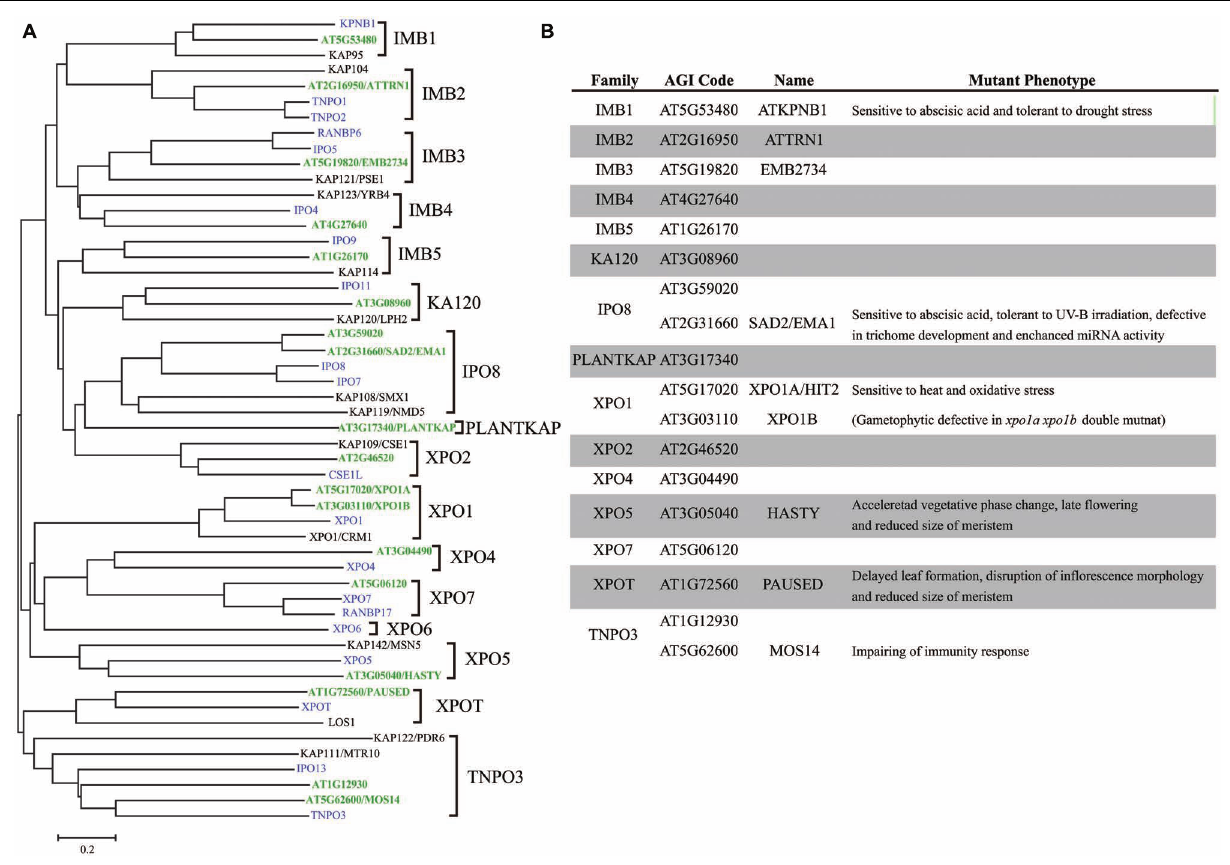
FIGURE 1 | Comparison of importin β family proteins in Arabidopsis , human, and yeast. (A) Phylogenetic tree of importin β family in Arabidopsis (green), human (blue), and yeast (black) constructed using the neighbor joining method. (B) Arabidopsis importin β family